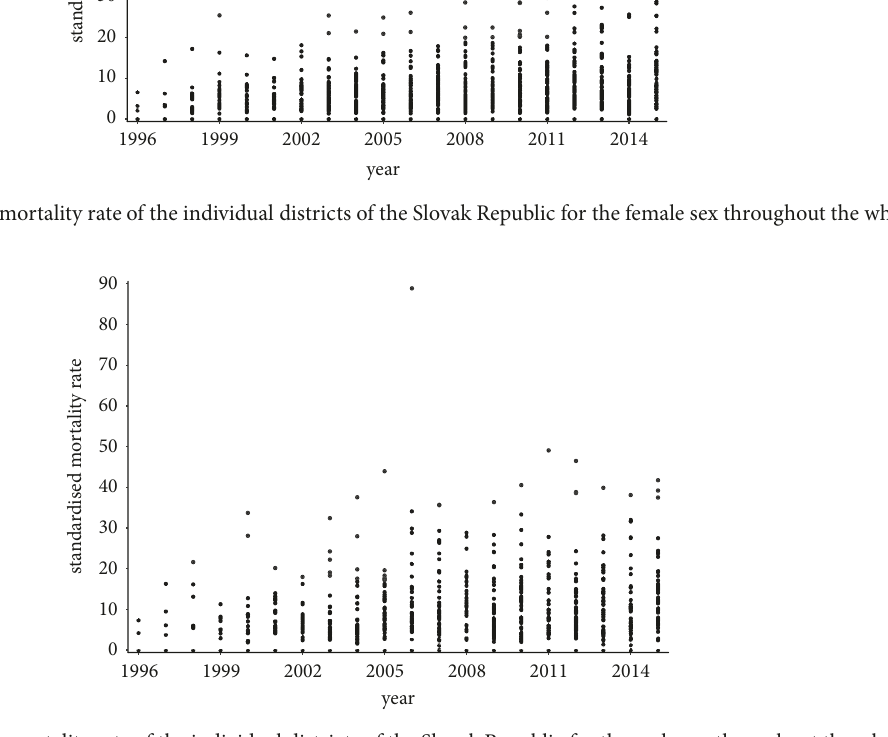
comparison, a median value of the districts variance equals 34.1182 and is represented by the Levoˇca District. A